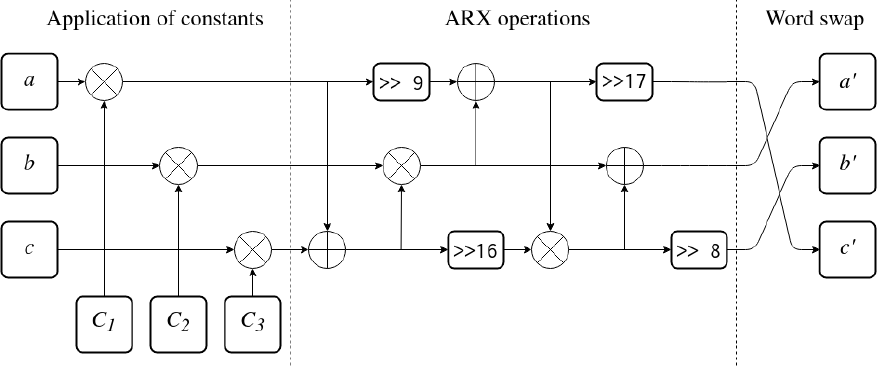
Figure 6. The f ot function (one third of the entire f